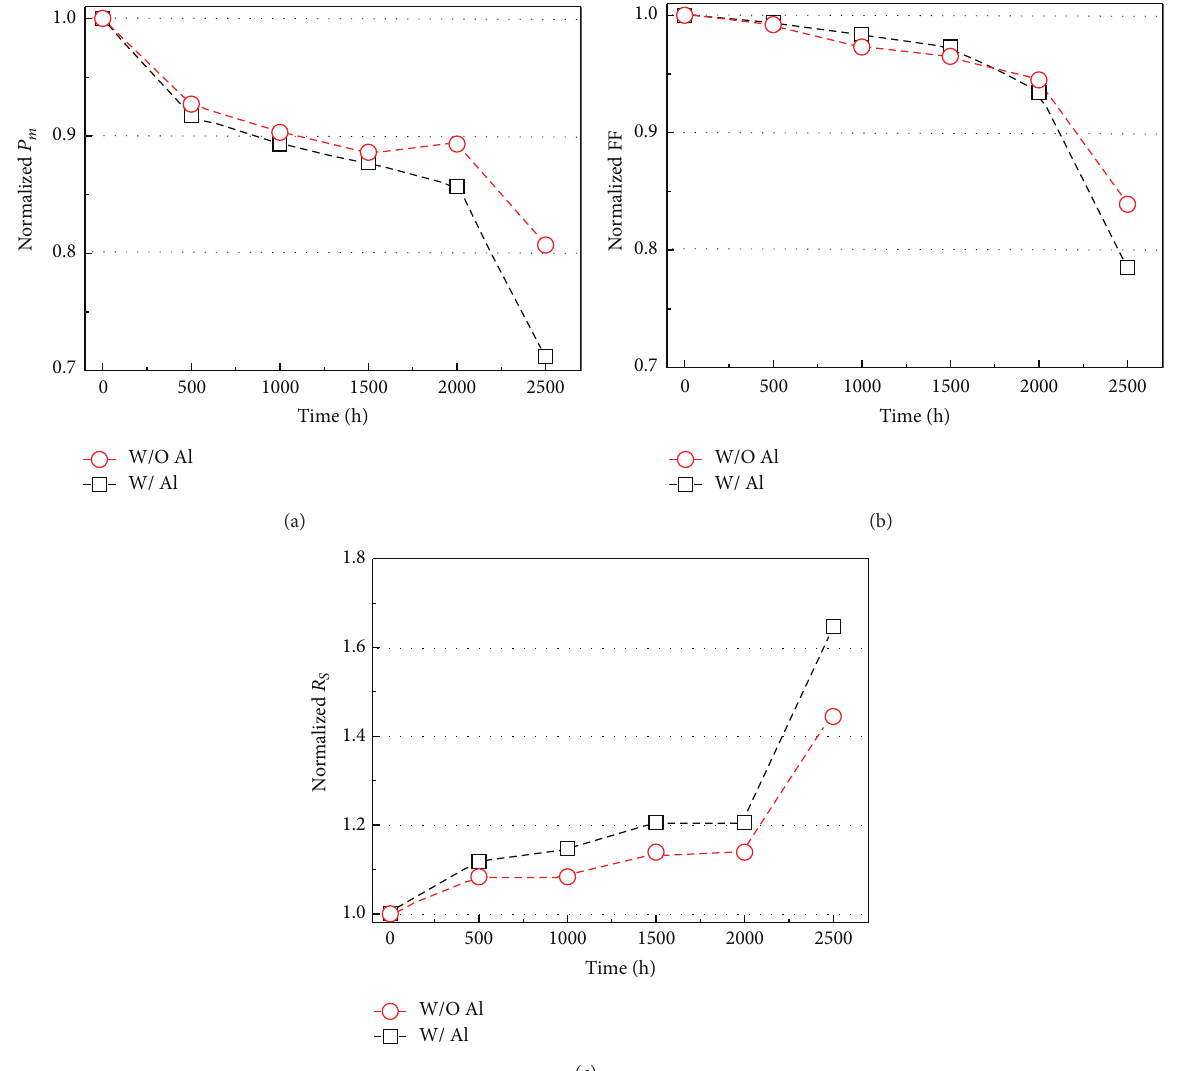
Figure 8: Change in average normalized electrical parameters of laminated PV modules: (a) maximum power ( 𝑃 𝑚 ), (b) fill factor (FF), and (c) series resistance ( 𝑅 𝑆